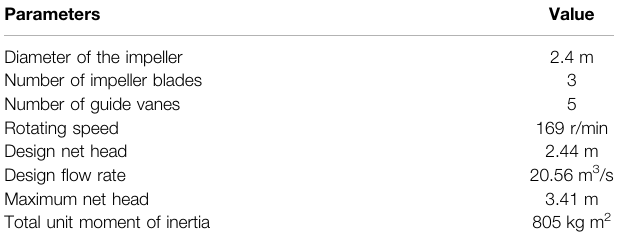
TABLE 1 | Characteristic parameters of the pumping station.